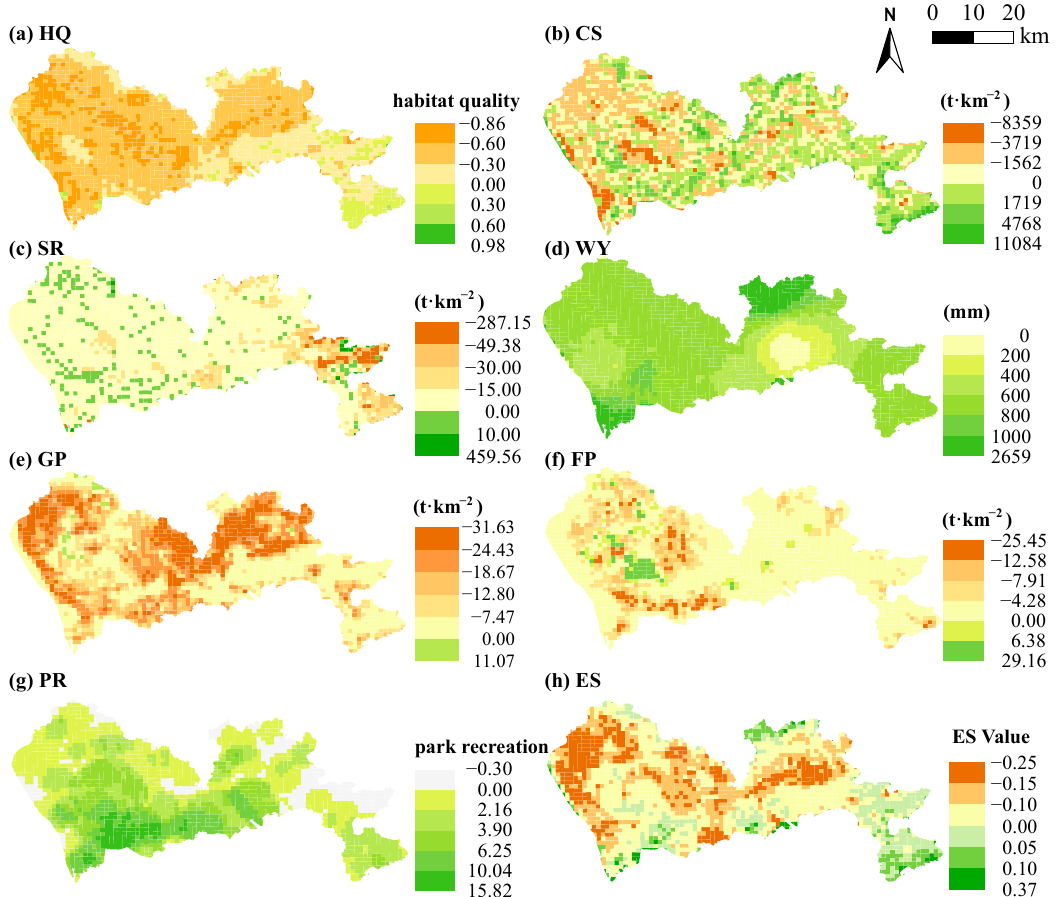
Figure 3. Spatial–temporal variations of ESs in Shenzhen during 1978–2018: ( a ) habitat quality; ( b ) carbon sequestration; ( c ) soil retention; ( d ) water yield; ( e ) grain production; ( f ) fruit production; ( g ) park recreation; ( h ) Average total ecosystem services changes.